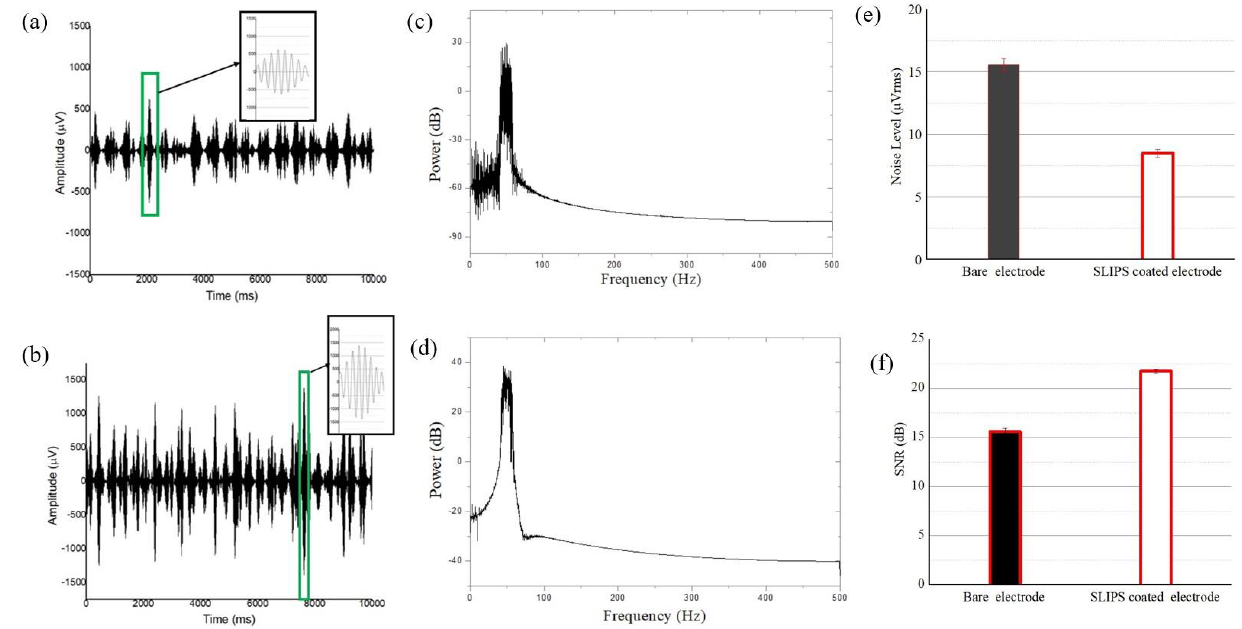
Figure 10. In vivo recording of the LFP signal from the ( a ) bare electrode, ( b ) SLIPS-coated electrode, ( c ) power density of bare ECoG electrode, ( d ) power density of SLIPS-coated ECoG electrode, ( e ) noise voltage level, and ( f ) SNR from both electrodes.